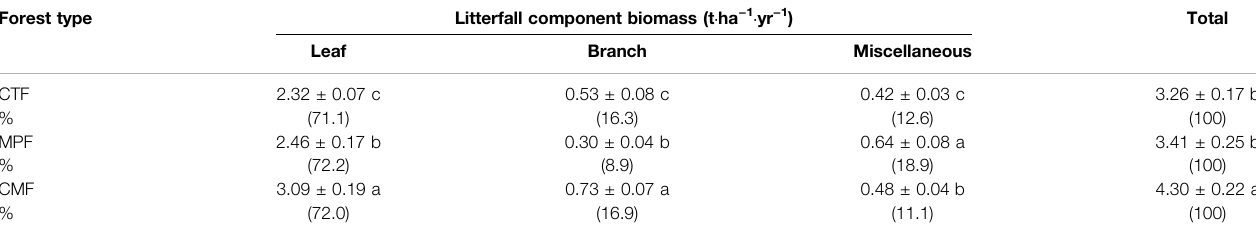
TABLE 2 | Annual biomass production and distribution percentage of litterfall components in the three subtropical forest types. Forest type